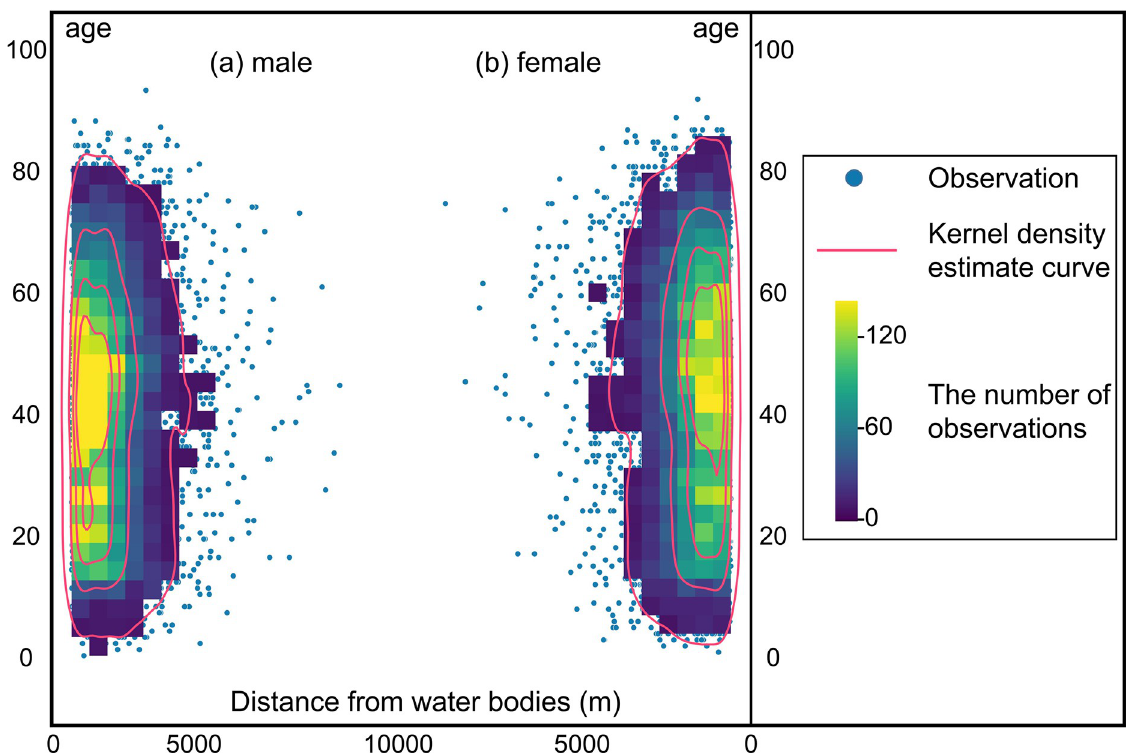
Fig 10. Bivariate distributions of the distance of HFRS cases from water bodies. The bivariate distributions are based on the age and sex of HFRS patients in Xi’an City.